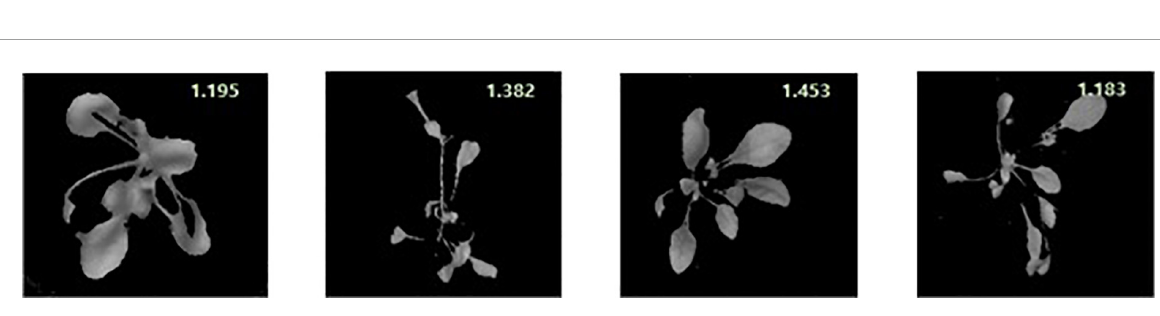
Figure 5 that the PLSR model is less biased toward the under- prediction or over-prediction of total phenolic compounds, and they are predicted accurately among these models despite various kinds of stress. Overall, the experiment results show that the PLSR model is better able to predict the total